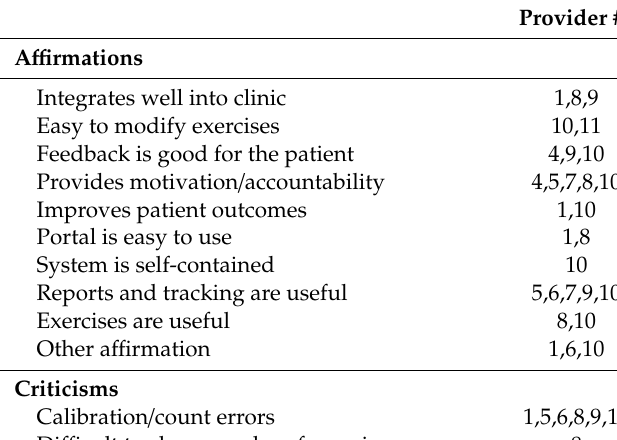
Table 8. Provider interviews (n =